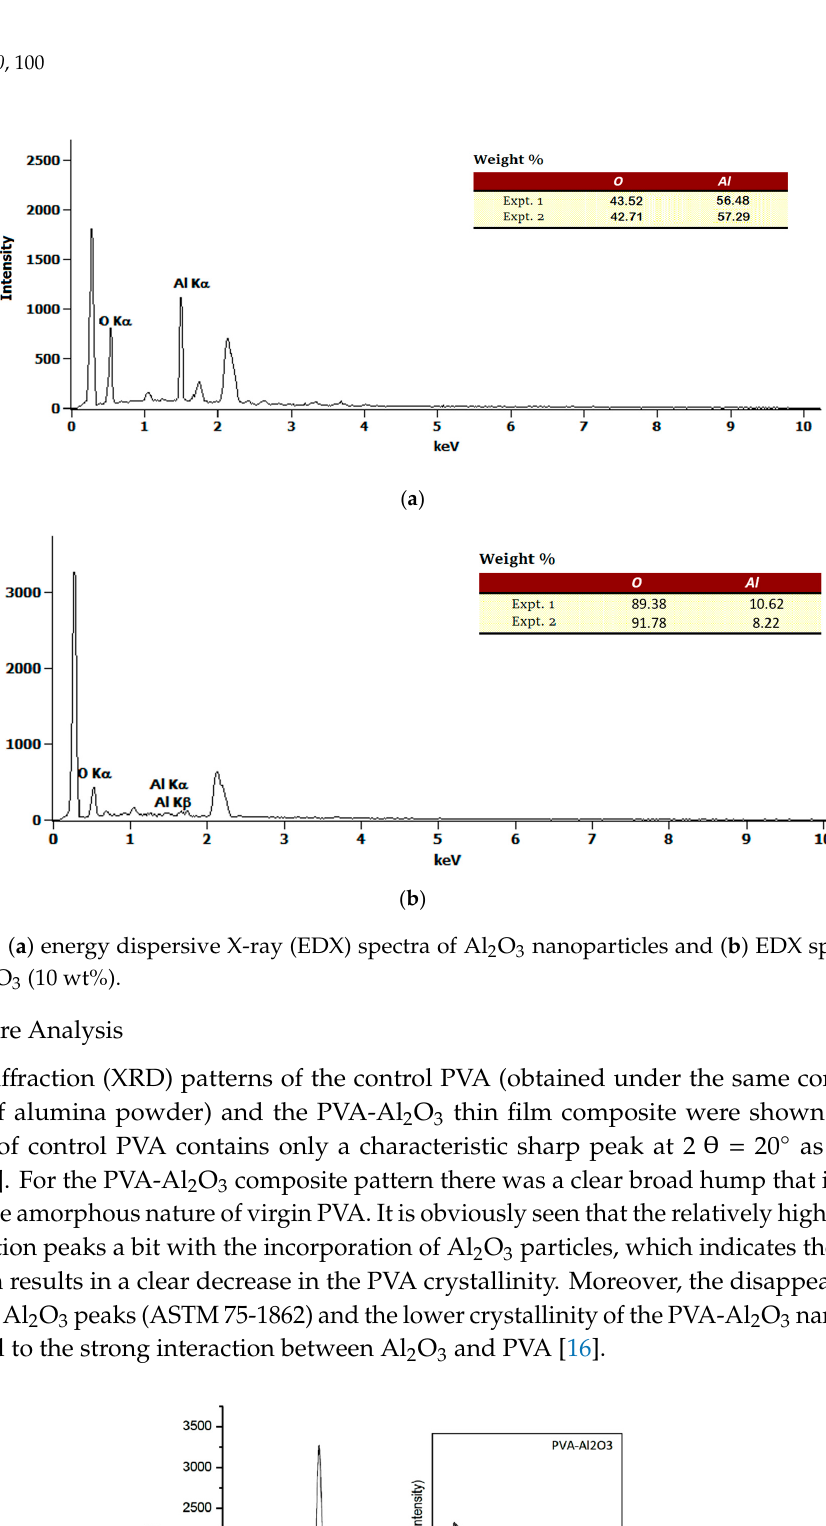
Figure 3. ( a ) SEM image of PVA; ( b ) SEM image of Al 2 O 3 nanoparticles; and ( c ) SEM image of PVA/A 2 O 3 film.